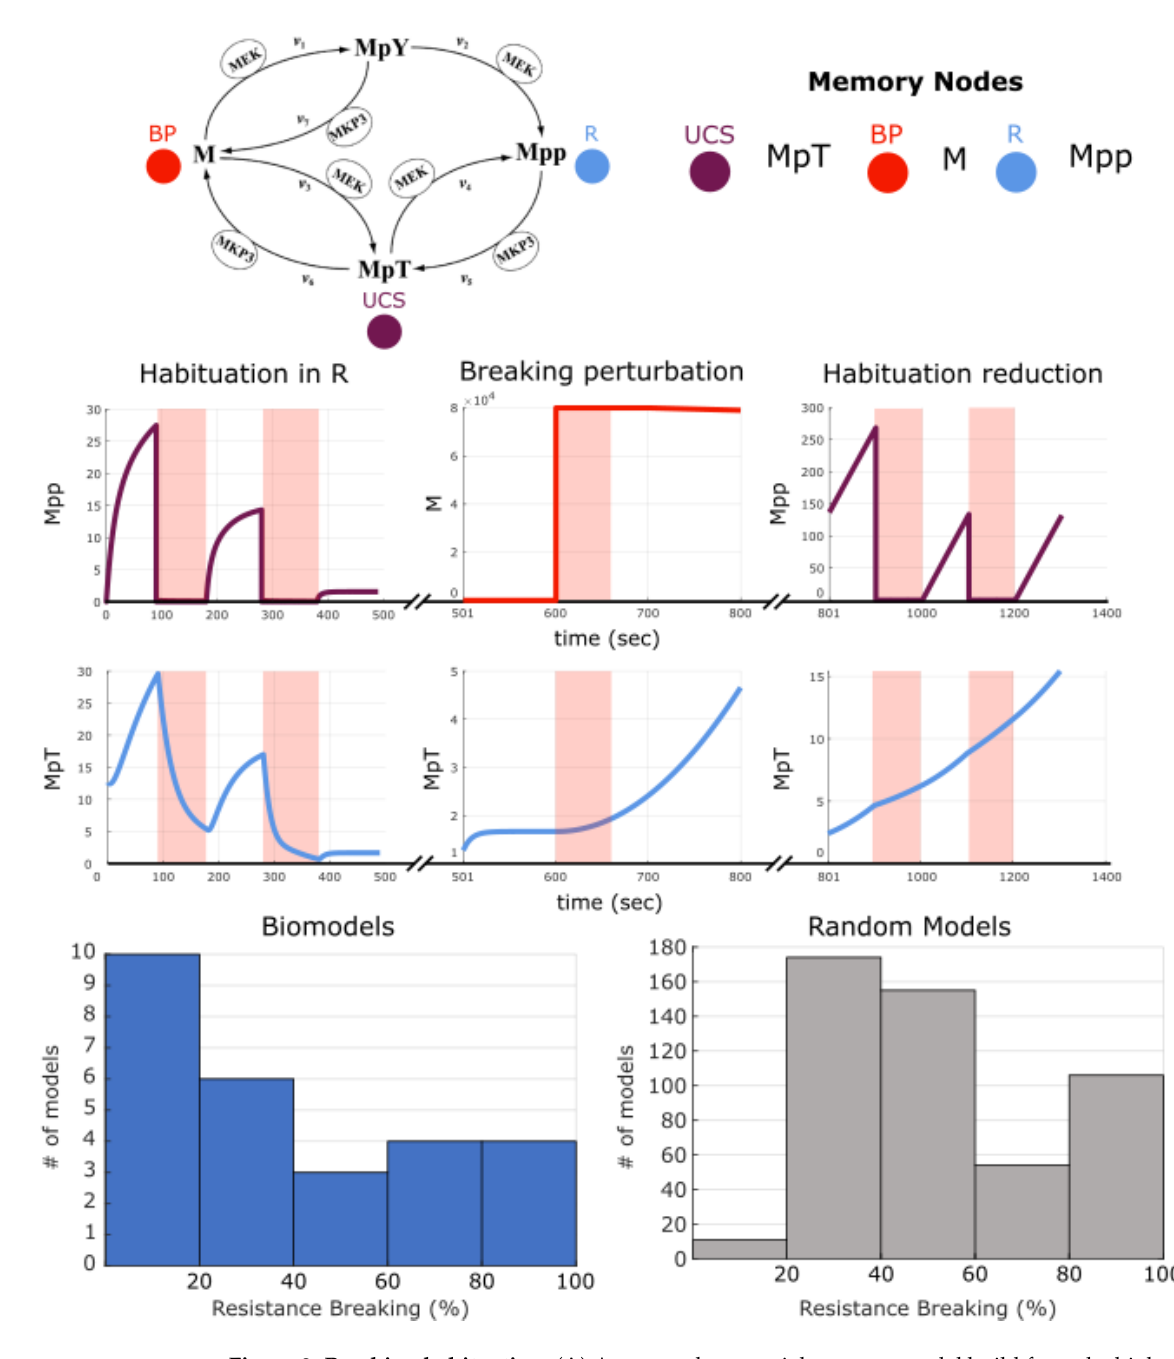
Figure 9. Breaking habituation. ( A ) An example potential memory model build from the biological model in [75] that shows both habituation to stimulation as well as breaking of that habituation through an alternative stimulation, a breaking perturbation (PB). ( B ) Time courses showing habituation (left), stimulation on the BP node (middle), and the subsequent habituation breaking (right). All graphs are a part of the same simulation and separated for visualization only. Red shaded areas indicate when a stimulation was delivered, either on the UCS or BP node. ( C ) Distribution of habituation breaking across all biological models and random networks. The x axis is measured as the percentage of memory models for a given biological model that show habituation breaking. We performed a Wilcoxon rank sum test applicable to un-equal samples to test the similarity of the distributions and they are significantly different ( p = 0.0022).